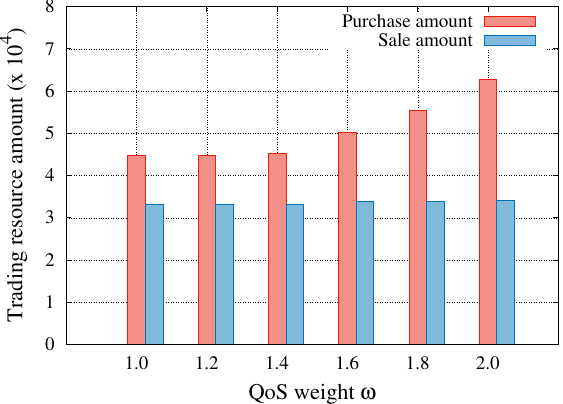
Figure 8. Trading resource amount with respect to the QoS weight